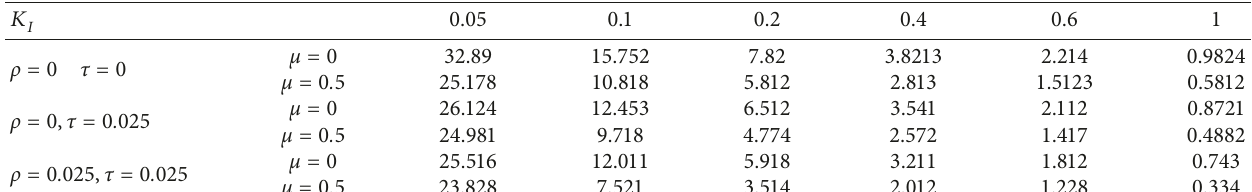
Table 3: Delay margin h ∝ K I under three situations of load disturbance (single-area LFC).